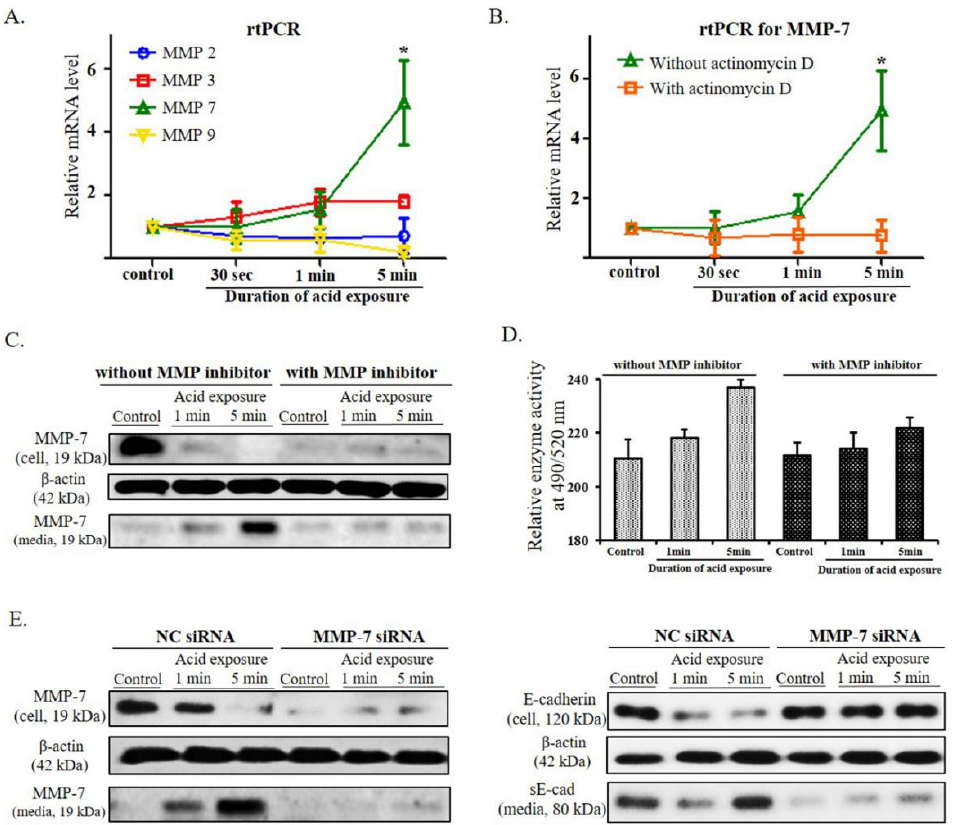
Figure 2. Changes in the expression of MMPs after acid exposure and changes in the expression and enzyme activity of MMP-7 according to MMP inhibitor treatment and MMP-7 knockdown. ( A ) As the duration of exposure to acid increases, the mRNA expression of MMP-2 and MMP-9 decrease, and that of MMP-3 and MMP-7 increase. The decrease in mRNA expression for MMP-9 and the increase in mRNA expression for MMP-7 at 5 min of acid exposure were particularly significant (* p < 0.05), while the changes in MMP-3 show an increasing tendency without a statistical significance. ( B ) When treated with actinomycin D, the mRNA expression of MMP-7 is not increased. ( C ) The intracellular decrease (cell) and extracellular increase (media) of the active forms of MMP-7 are elicited by increases in acid exposure time, while these changes are not identified after treatment with an MMP inhibitor. ( D ) As the cells are exposed to acid for longer periods of time, the enzyme activity of MMP-7 on the 5-FAM / QXL TM 520 FRET peptide significantly decreases after treatment with an MMP inhibitor. ( E ) The expression of the active form of MMP-7 markedly decreases via the MMP-7 siRNA knockdown compared with that of negative control (NC siRNA). MMP-7 siRNA- transfected cells do not exhibit a decrease in the level of cellular E-cadherin or an increase in the level of sE-cad in culture media after acid